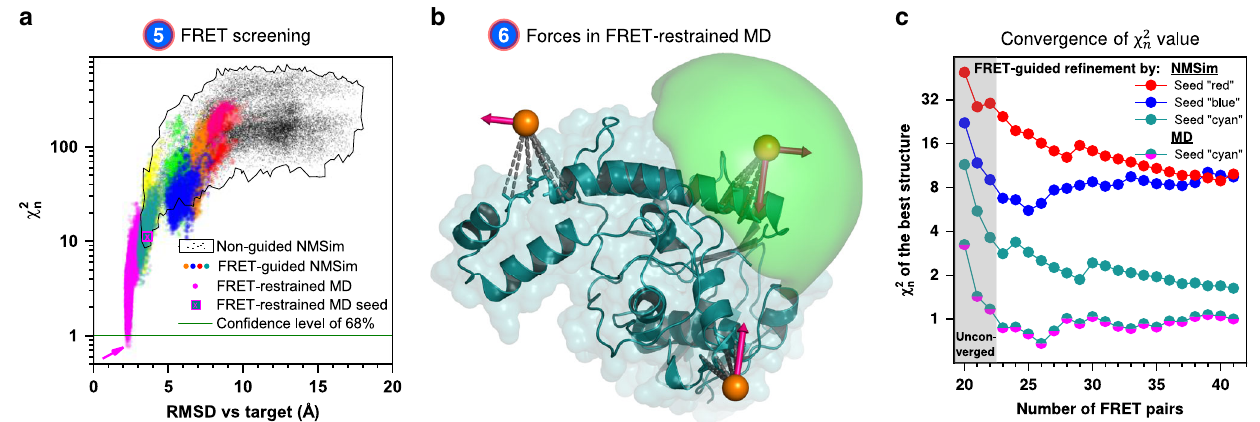
values and RMSD against the crystal structure (target) of different conforma- Fig. 3 FRET-guided modeling of the E. coli protein YaaA. a FRET χ 2 n tions (points). The black points represent models obtained by unrestrained NMSim sampling starting from homology models. Colored points represent FRET-guided NMSim simulations. The magenta points represent FRET-restrained MD simulations. Guided simulations starting from different homology models are shown in different colors. The magenta arrow points to the structure with the lowest χ 2 . b Attachment (dashed gray) of pseudoatoms (orange n spheres) and application of FRET restraints (pink arrows) in FRET-restrained MD simulations. The accessible volume of a fl uorophore is shown as green surface. c χ 2 of the FRET-guided models depending on the number of cross-validation FRET pairs, number of fi t parameters is constant ( N fi t.param. = 19). n Each curve represents a best conformer generated by FRET-guided NMSim or FRET-restrained MD simulations using different seed structures. χ 2 starts to n converge with ~23 selected FRET pairs (four cross-validation FRET pairs), where the curves reach a plateau. The line colors correspond to the color of the structures in Fig. 2a. Source data are provided as a Source Data fi